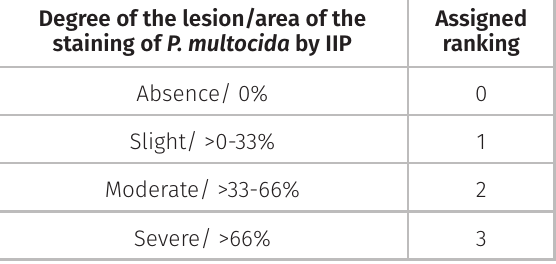
Table II. Ranking according to the degree of severity of each change or lesion in the nasal septum or lung and the percentage of area labeling of P. multocida by IIP over the epithelium of the nasal septum or lung. Degree of the lesion/area of the Assigned staining of P. multocida by IIP ranking Absence/ 0%